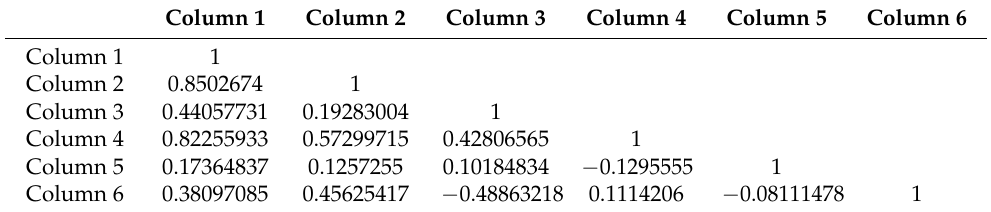
Table 18. Correlation matrix for model